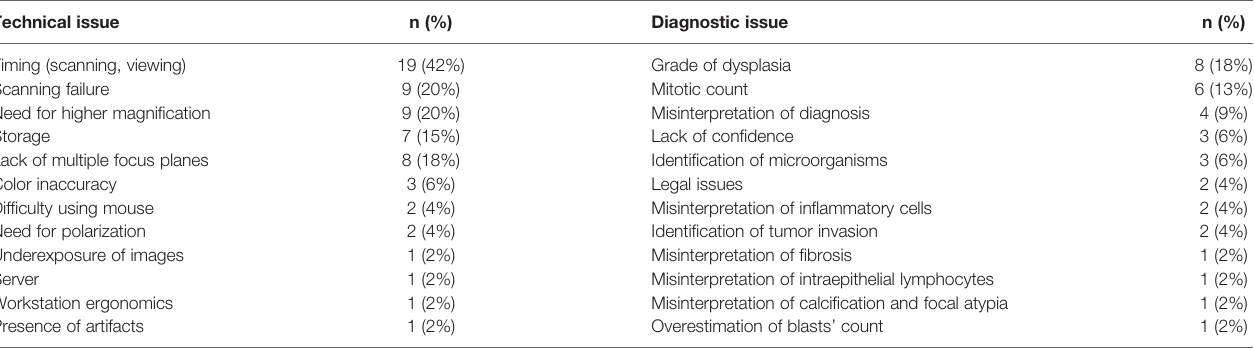
TABLE 1 | Characteristics of technical and diagnostic issues of the included